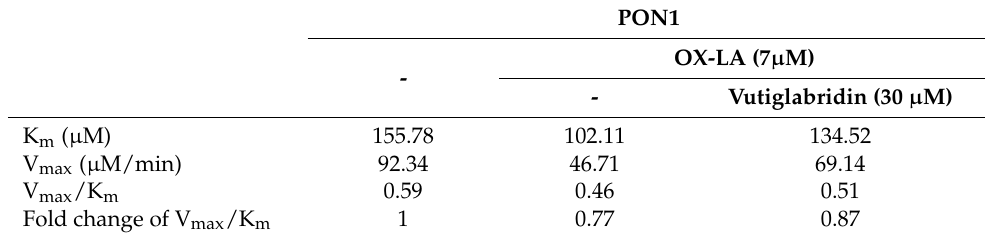
Table 1. Analysis of rePON1 enzyme kinetics of vutiglabridin under OX-LA stress conditions. The enzyme kinetic analysis of the recombinant PON1 was analyzed using a substrate, TBBL. Oxidized linoleic acid (OX-LA) and vutiglabridin were incubated in rePON1, and K m and V max values were extracted from the rePON1 kinetic graph using the iFIT program. V max /K m was used as an index to see the catalytic function of the